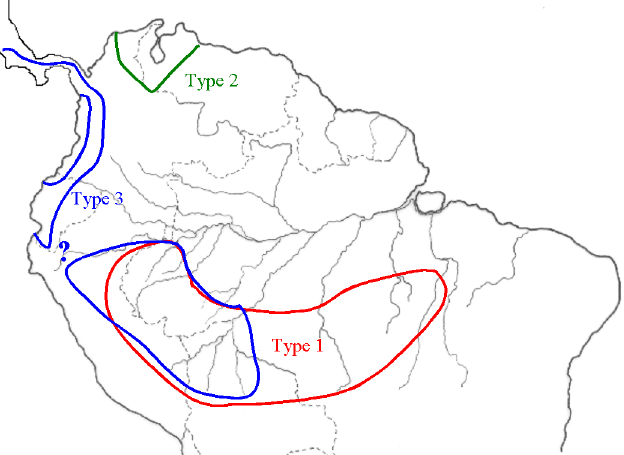
Figure 1. Distribution of the three wild types of Bactris gasiapes var. chichagui